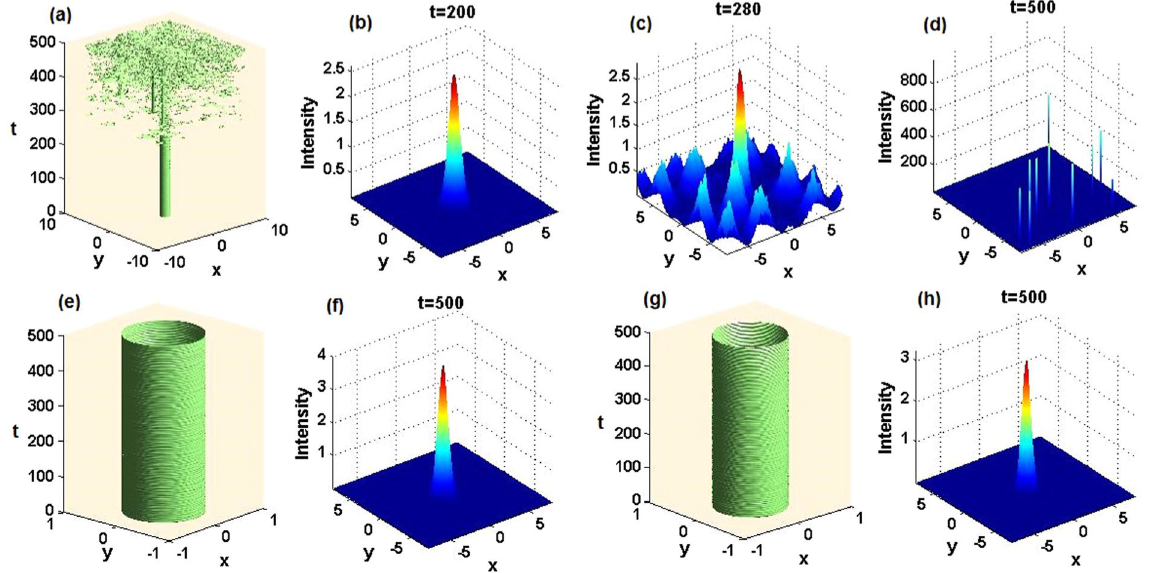
Figure 13. Stable and unstable evolution of 2D solitons. ( a ) The unstable evolution in terms of the intensity isosurfaces, corresponding to half the maximum initial intensity, of the 2D soliton from Fig. 9 (these and other results are virtually identical for exact solitons and their numerically found counterparts); ( b ) apparently stable and ( c ) intermediate states with emergent instability states; ( d ) the unstable final state. ( e ) The stable evolution of the soliton from Fig. 10, and ( f ) its final shape. ( g ) The stable evolution of the soliton from Fig. 11, and ( h ) its final shape. Note that t-axes should be z-axes in ( a , e ) and “t = ” should be “z = ” in ( b , c , d , f , g , h